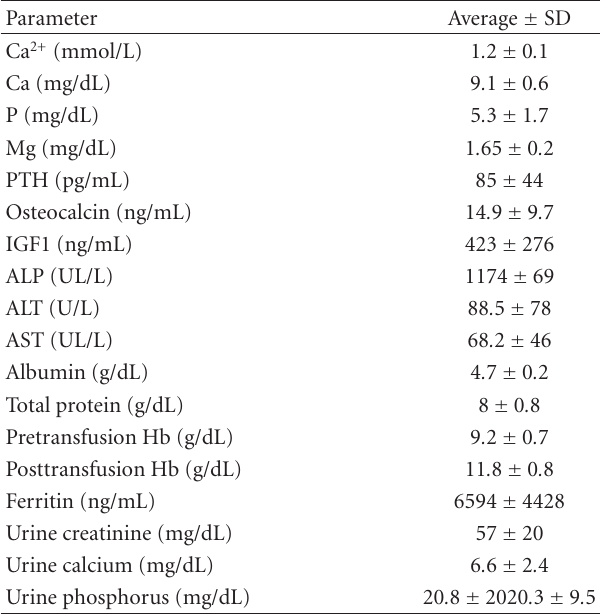
Table 1: Particulars of the